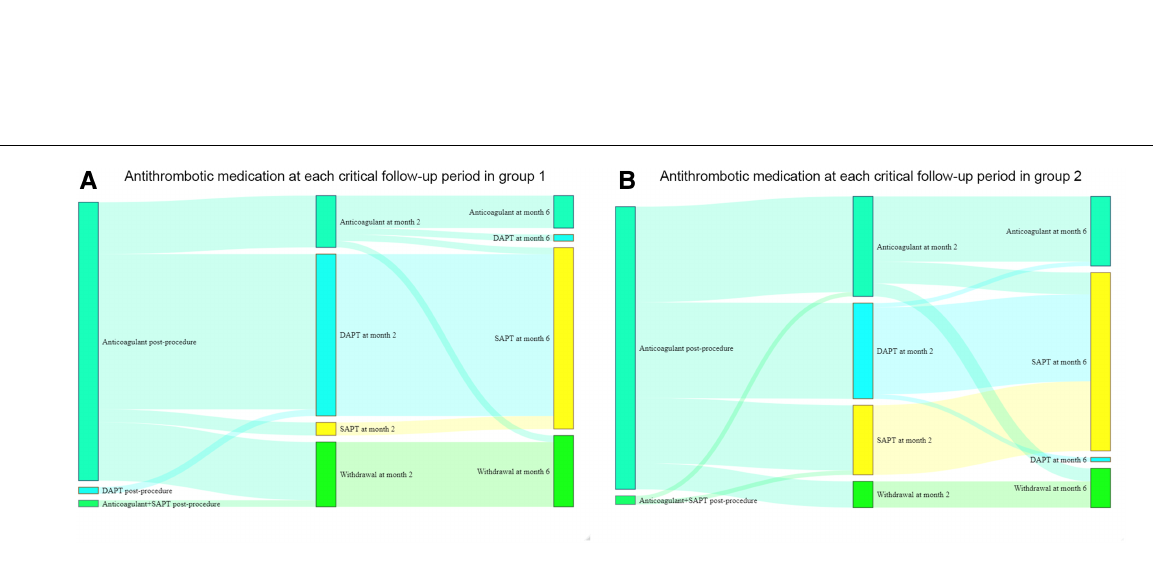
FIGURE 4 Antithrombotic medication at each critical follow-up points in different groups. DAPT, dual antiplatelet therapy; SAPT, single antiplatelet